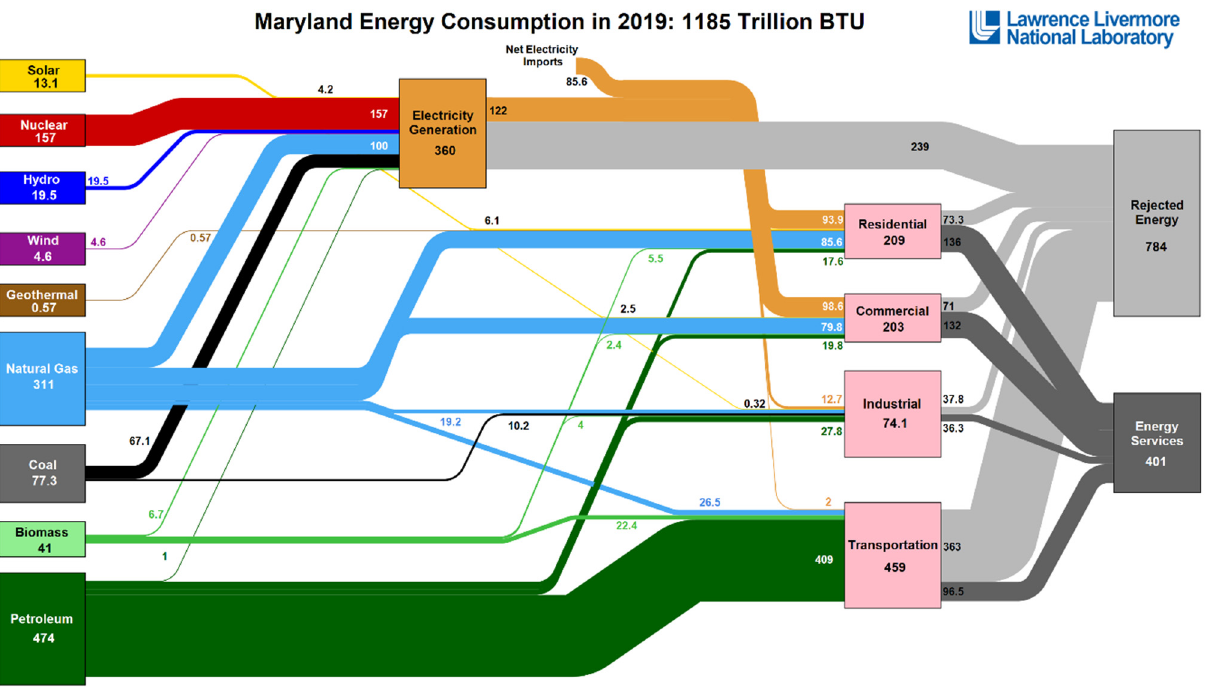
Figure 2. Energy flow diagrams constructed by the Lawrence Livermore National Laboratory. Data used to construct the diagram were collected by the Department of Energy and Energy Information Administration. The numbers within each compartment’s box are the amounts of energy in trillion Btu present. The numbers along lines, or flows, are the amount of energy in trillion Btu going into another compartment [16,17].